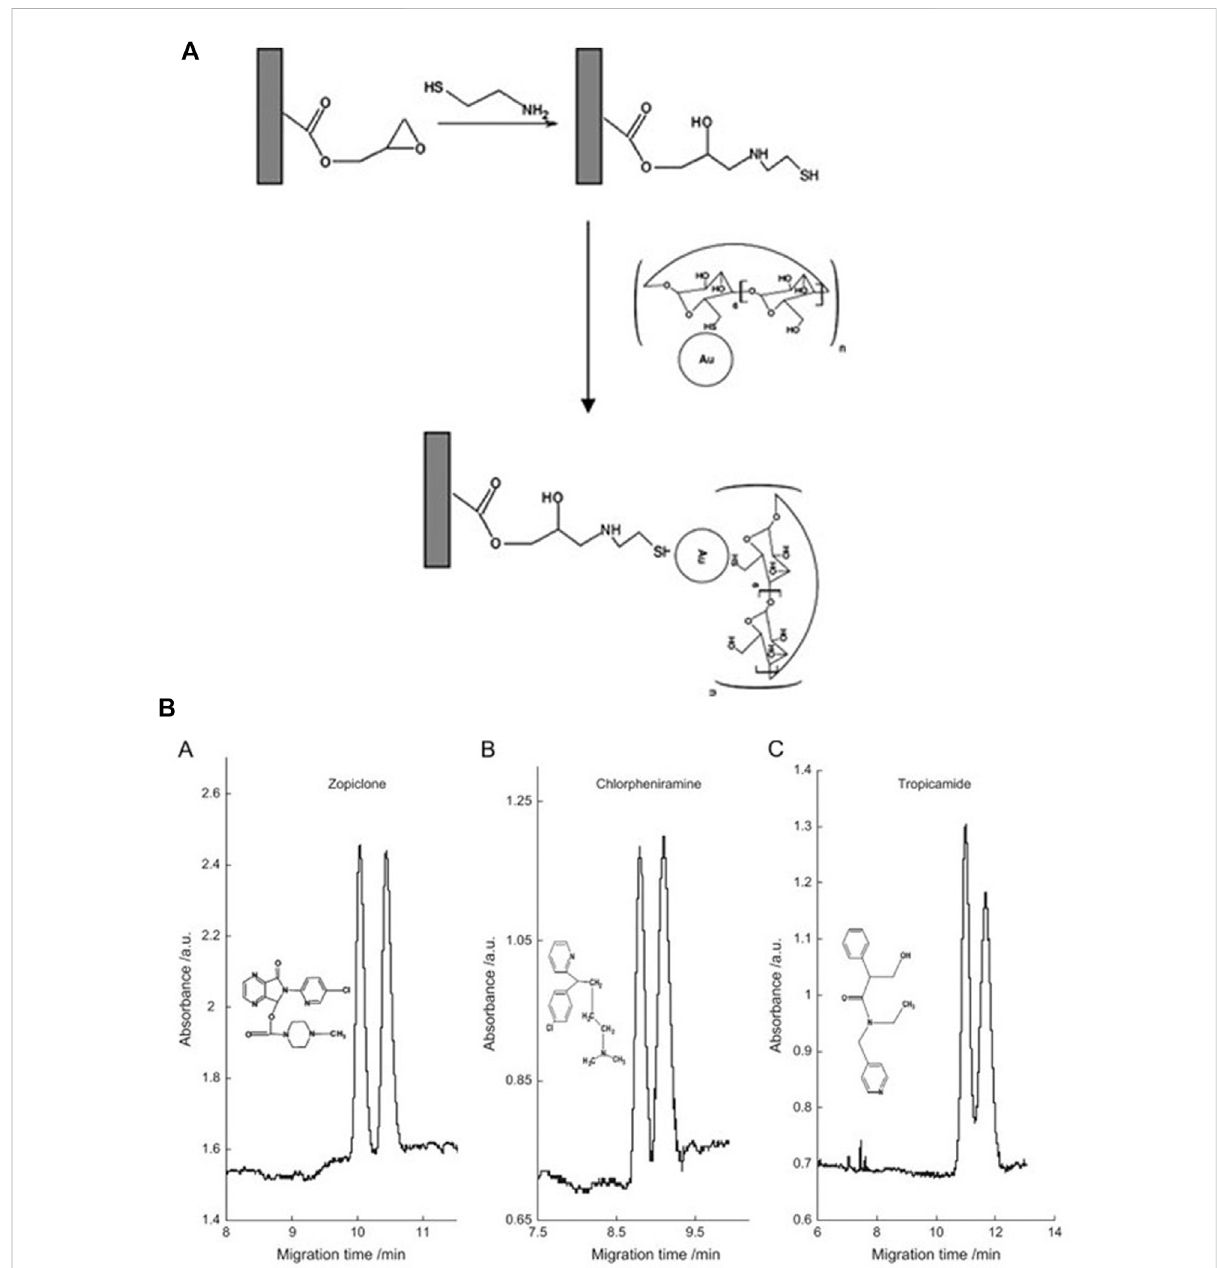
FIGURE 9 (A) : Reaction scheme for the fabrication of the CD-GNP-modi fi ed monolithic column (B) : Electropherograms of separations of three drug enantiomer pairs using the CD-GNP-modi fi ed monolithic columns. A 25 mM phosphate buffer (pH 3.0) was used as the running buffer. The separation electric fi eld strength was 312.5 V/cm. Detection was carried out on-column at 214 nm. Samples were injected electrokinetically at 5 kV for 3 s. Reprinted with permission from Ref. (Li M. et al., 2013). Copyright 2013